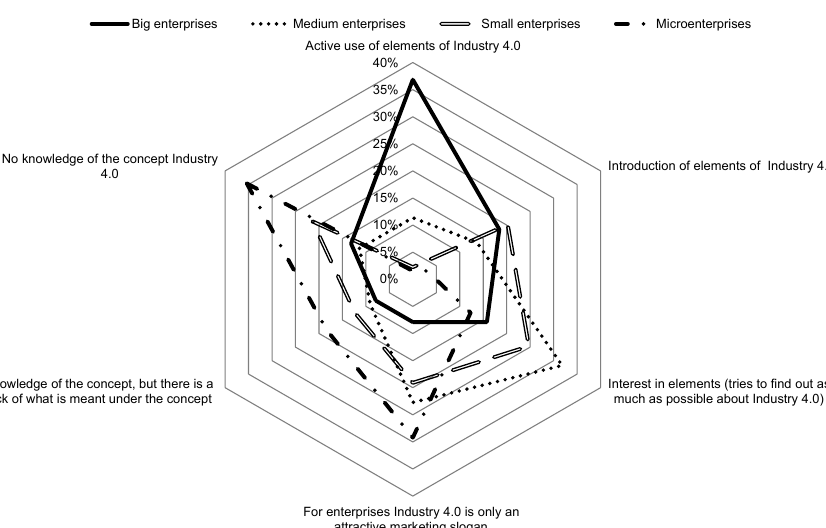
Fig. 2 – Knowledge of Industry 4.0 by Czech engineering enterprises. Source: Survey